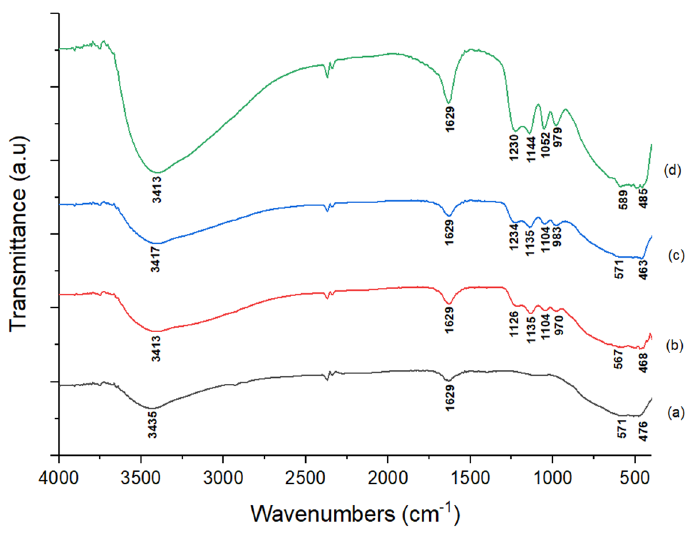
Figure 1. FTIR spectra of ( a ) TS0, ( b ) TS1, ( c ) TS2, and ( d ) TS3.